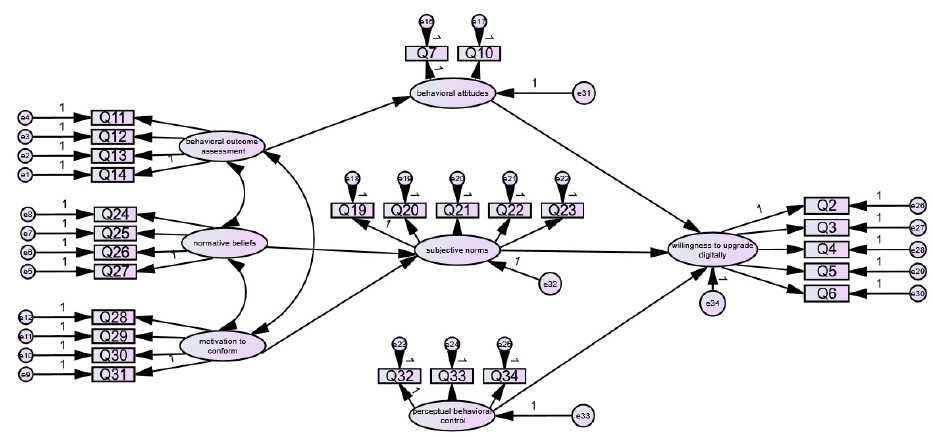
Figure 2. Initial path of willingness to digitally upgrade rural e-commerce.